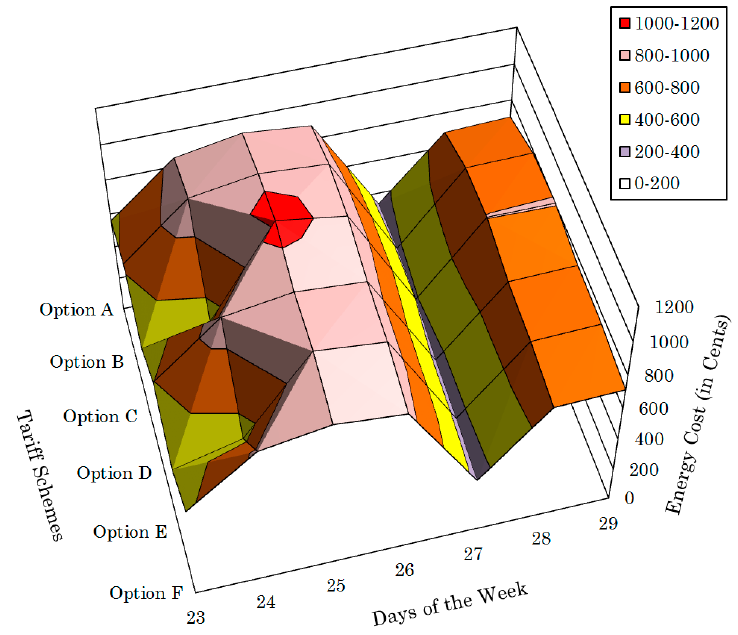
Figure 14. The consumed energy cost in cents by the MPC of the controlled AC unit by employing the 6 options of ToU rates.